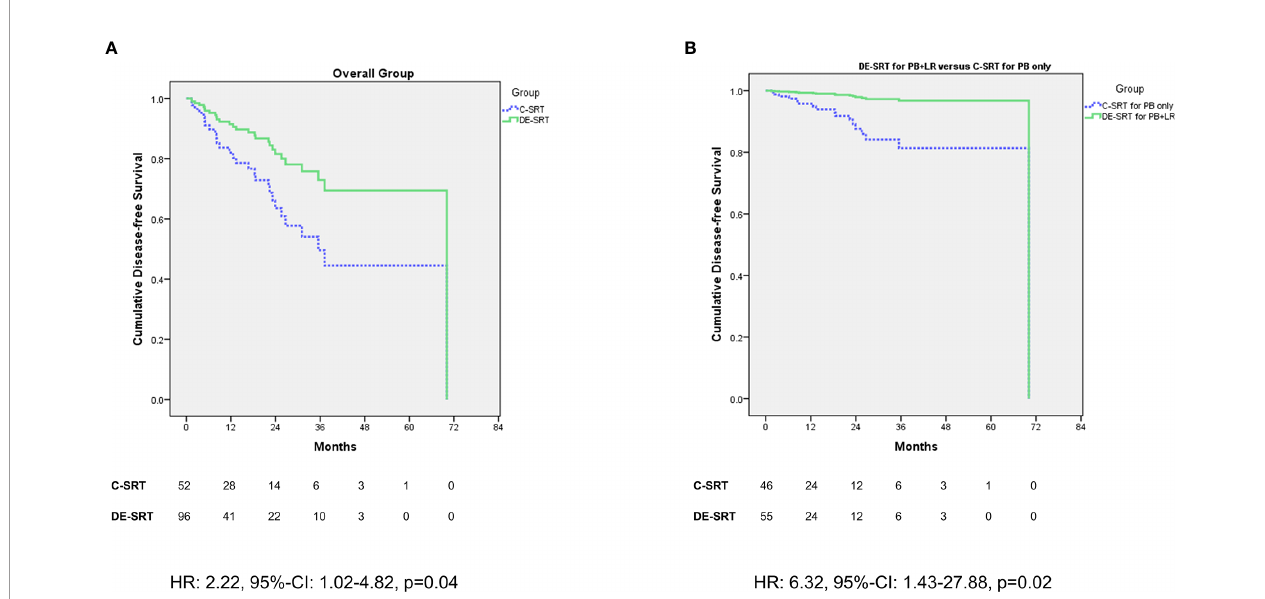
FIGURE 1 | Cox regression (adjusted for the use of additive androgen deprivation therapy) of disease-free survival (DFS) for dose-escalated salvage radiotherapy (DE-SRT) versus conventional salvage radiotherapy (C-SRT) in the overall group (A) and subgroup of patients with DE-SRT for the prostate bed (PB) and local recurrence versus C-SRT for the PB only (B) (HR, hazard ratio; 95%-CI, 95%-con fi dence interval).